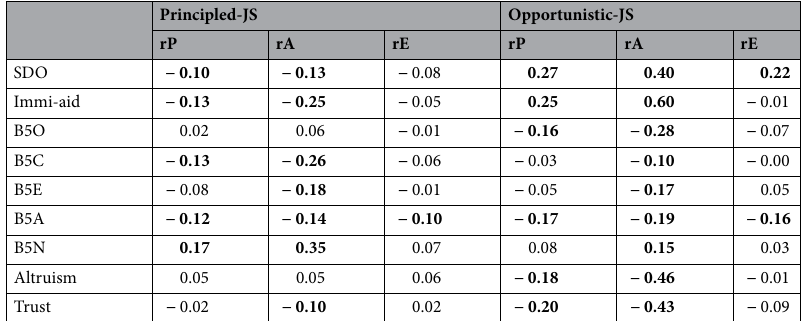
Table 5. Correlations between factor scores and relevant traits. Principled-JS factor scores from the factor with significant positive loadings on all 8 JS items, Opportunistic-JS factor scores from the factor with positive loadings on the two Victim sensitivity items and negative loadings on the remaining 6 items, rP Phenotypic correlation, rA Additive genetic correlation, rE unique-environmental correlation, SDO Social Dominance Orientation, Immi-aid opposition to immigration and foreign aid, B5O Big Five Openness to Experience, B5C Big Five Conscientiousness, B5E Big Five Extraversion, B5A Big Five Agreeableness, B5N Big Five Neuroticism, Altruism Frequency of various altruistic behaviors, Trust Interpersonal trust. Bold font is used for numbers > |0.10|, to highlight practical significance. All correlations larger than |0.07| are statistically significant at p <